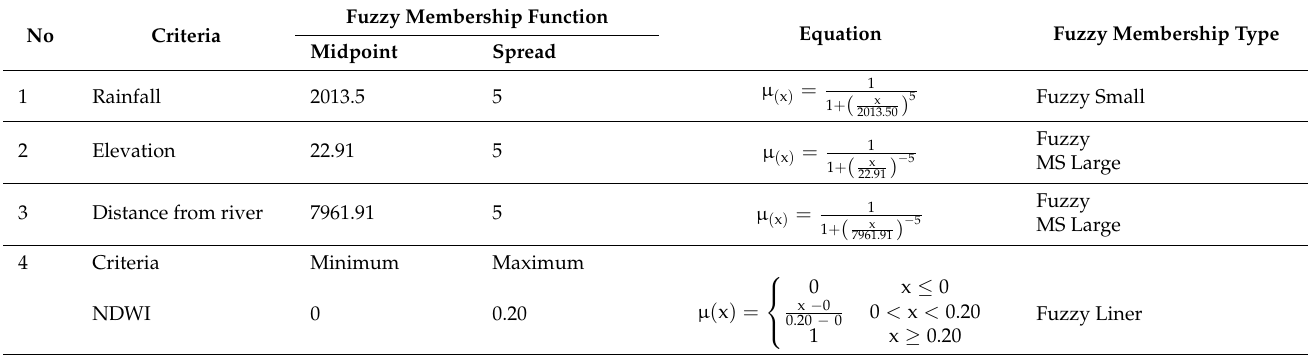
Table 3. Fuzzy membership function for inundation